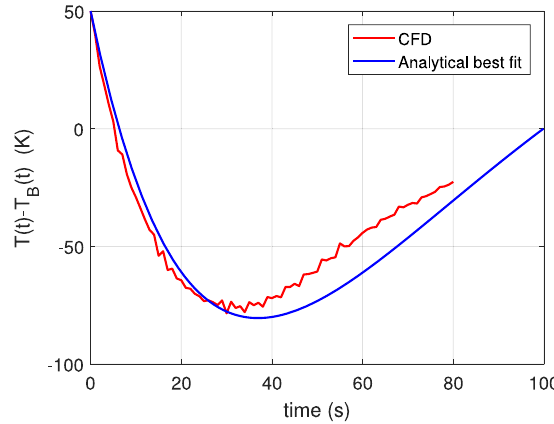
Fig. 3. Difference between average and outflow molten salt tem- peratures as a function of time. Red: CFD simulation of the draining transient; blue: analytical